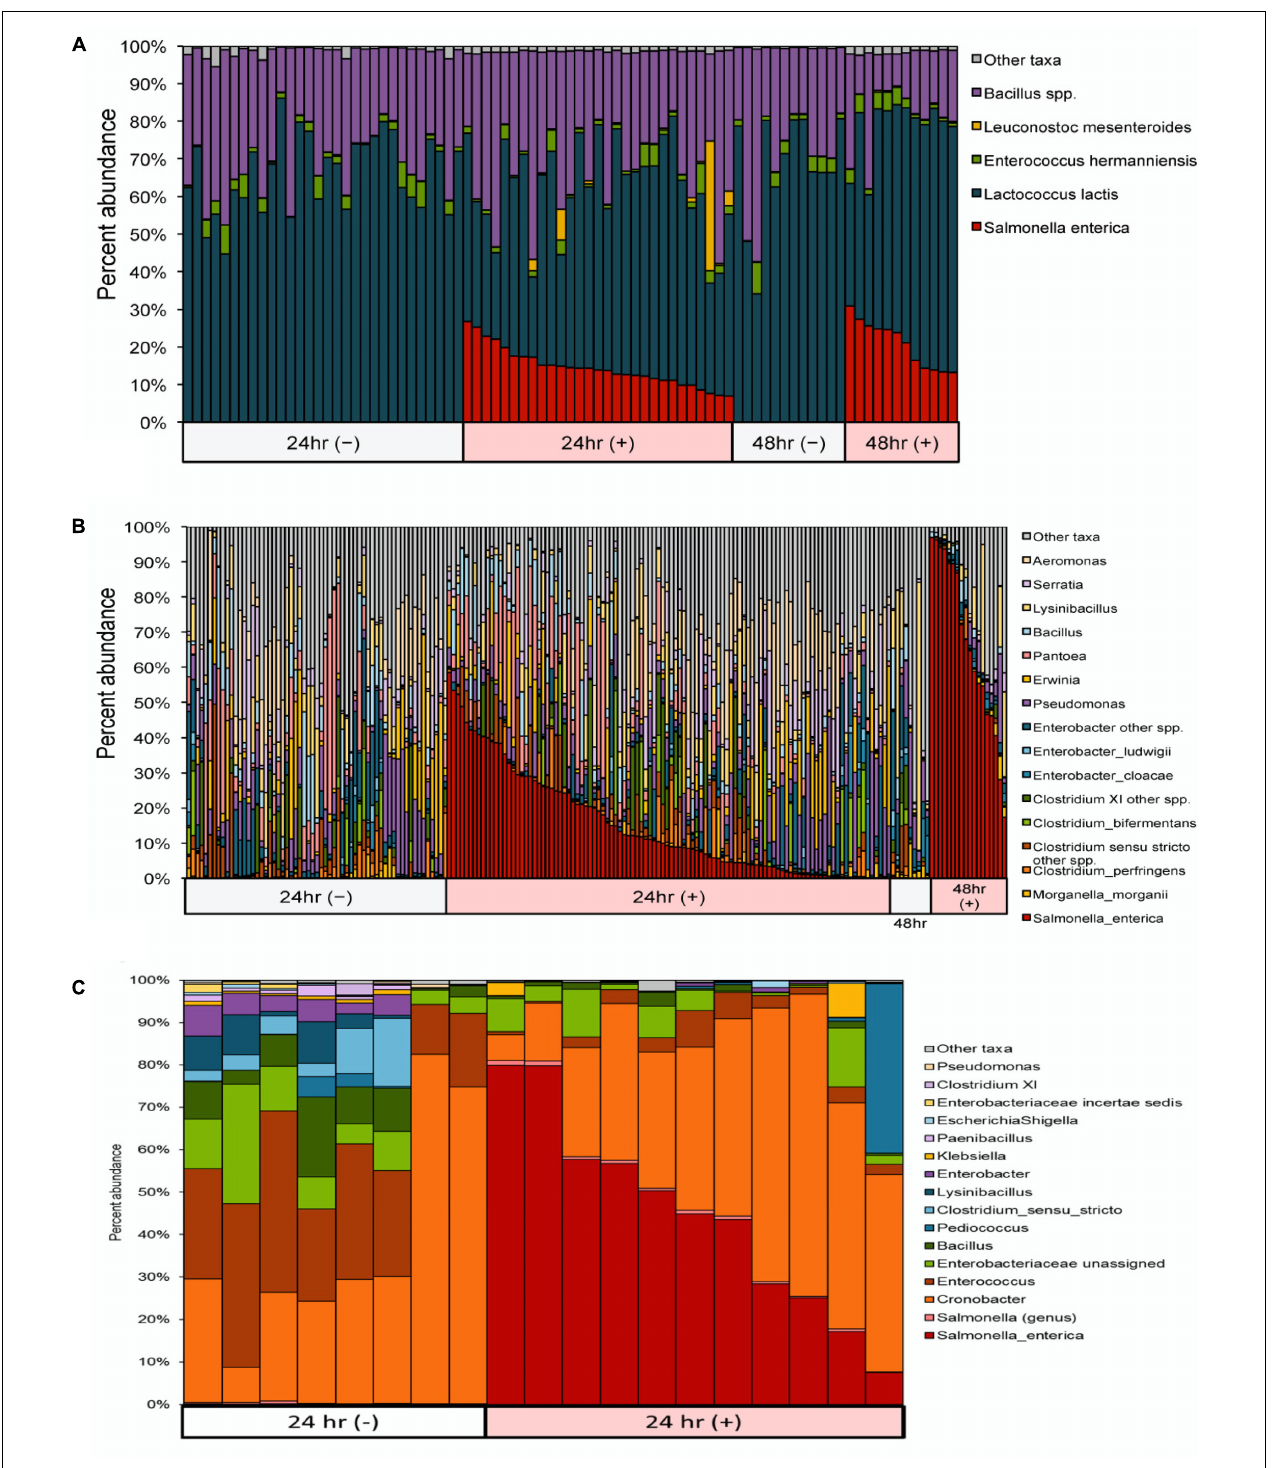
FIGURE 3 | Microbiome profiles for (A) ice cream and (B) cilantro samples after 24 and 48 h enrichments, and (C) chili powder samples after 24 h enrichments, sorted by Salmonella culture status ( ± ). We detect S. enterica with at least 0.1% abundance in 98% of Salmonella culture-positive samples. Ice cream samples are dominated by Lactococcus lactis , while cilantro- and chili powder-associated communities harbor increased overall diversity including members of Clostridia and Enterobacter .